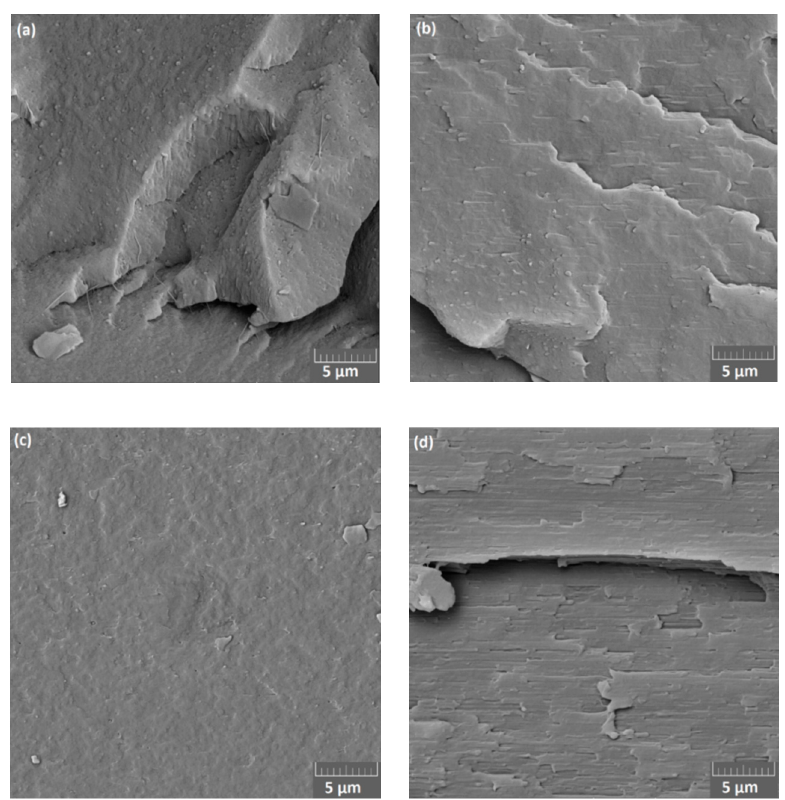
Figure 7. SEM of cryofractured surfaces of flat films made of PBAT/PLA blends: ( a ) 90/10 in CD, ( b ) 90/10 in MD, ( c ) 60/40 in CD, ( d ) 60/40 in MD. ( b ) 90 / 10 in MD, ( c ) 60 / 40 in CD, ( d ) 60 / 40 in